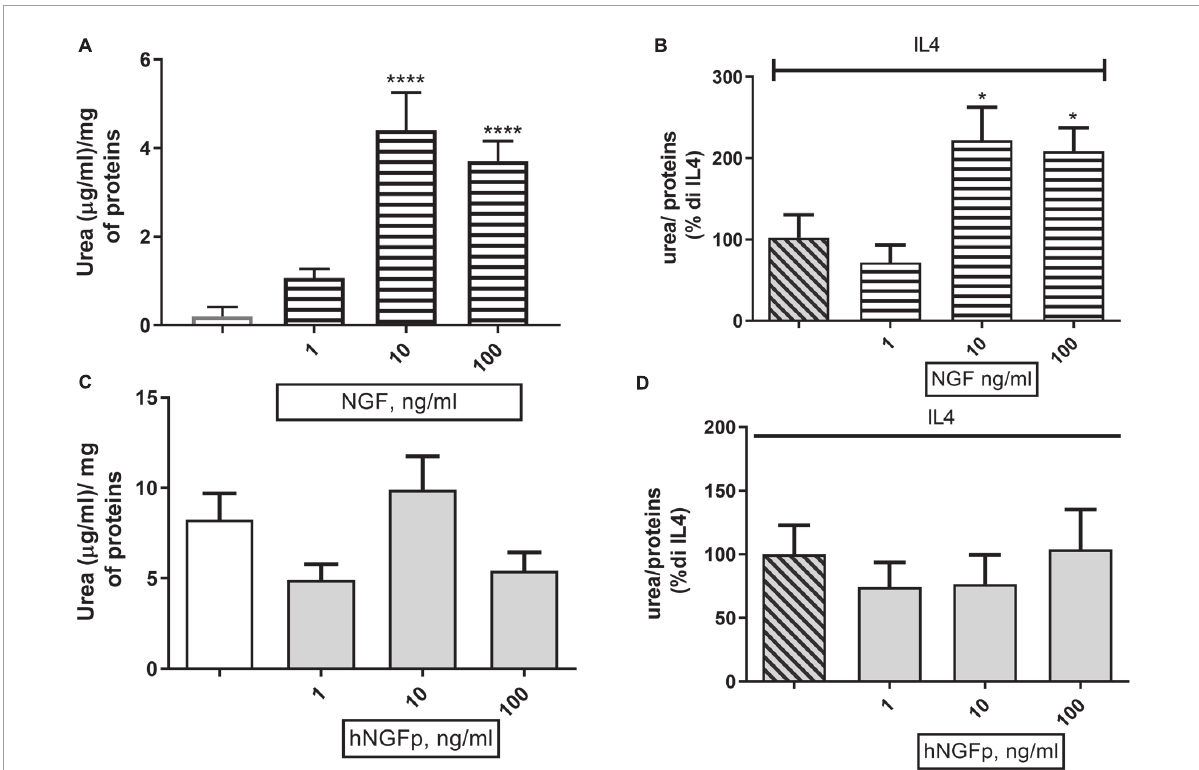
FIGURE6 Effects on urea pathway after 48 h nerve growth factor (NGF) treatments in CHME-5. (A,B) The effects of 1–10 or 100 ng/ml of NGF on urea production under basal condition and in co-stimulation with IL4 respectively. (C,D) The effects of 1–10 or 100 ng/ml of painless human Nerve Growth Factor (hNGFp) on urea production under basal condition and in co-stimulation with IL4 respectively. * p < 0.05 and **** p < 0.0001 vs. IL4. One-way ANOVA analysis followed by Bonferroni’s post-test was carried out. (A) F (5, 30) = 16.54; P < 0.0001. (B) F (3, 19) = 6.368; P = 0.0036. Data are expressed as mean ± SEM. The experiment was repeated four times with similar